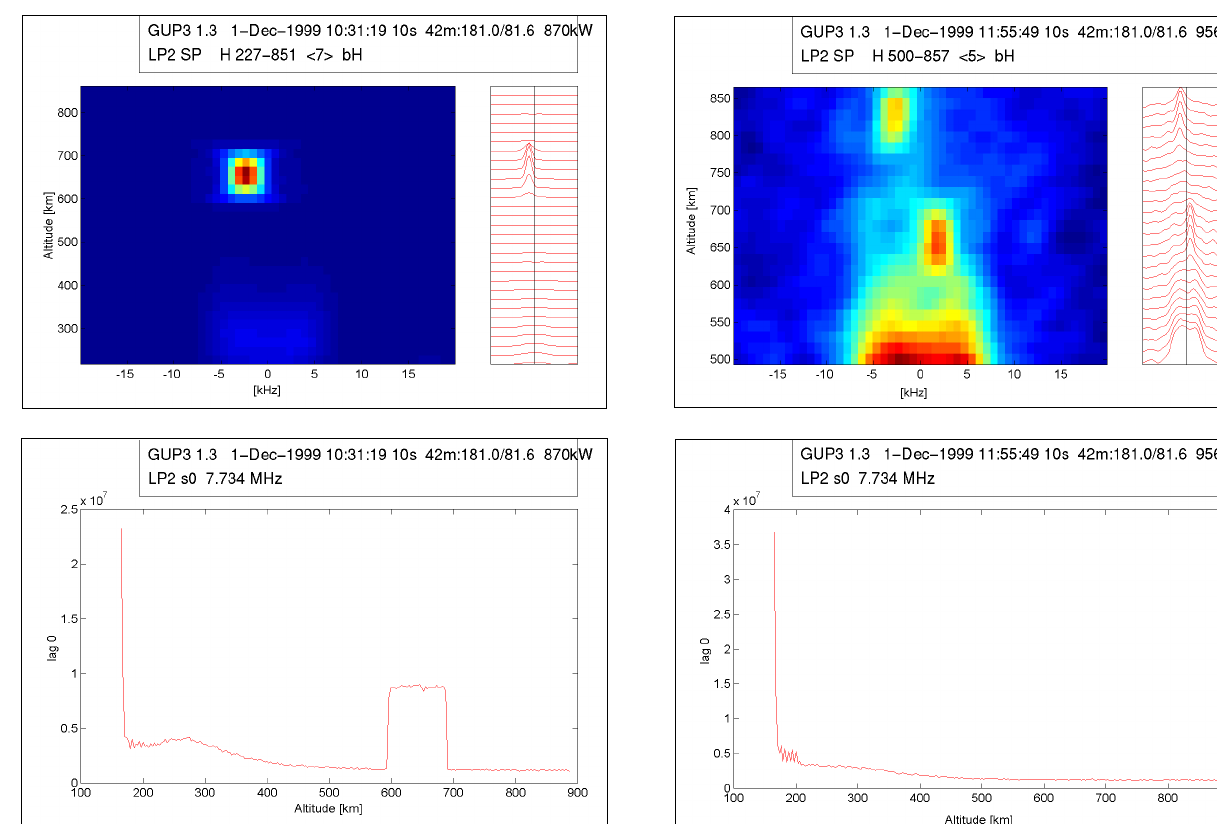
Fig. 1. Results showing (a) spectra, and (b) power profile for LP2 data at 10:31:19UT, 1 December 1999, using EISCAT rtg3 program when a probable satellite was seen in the beam.